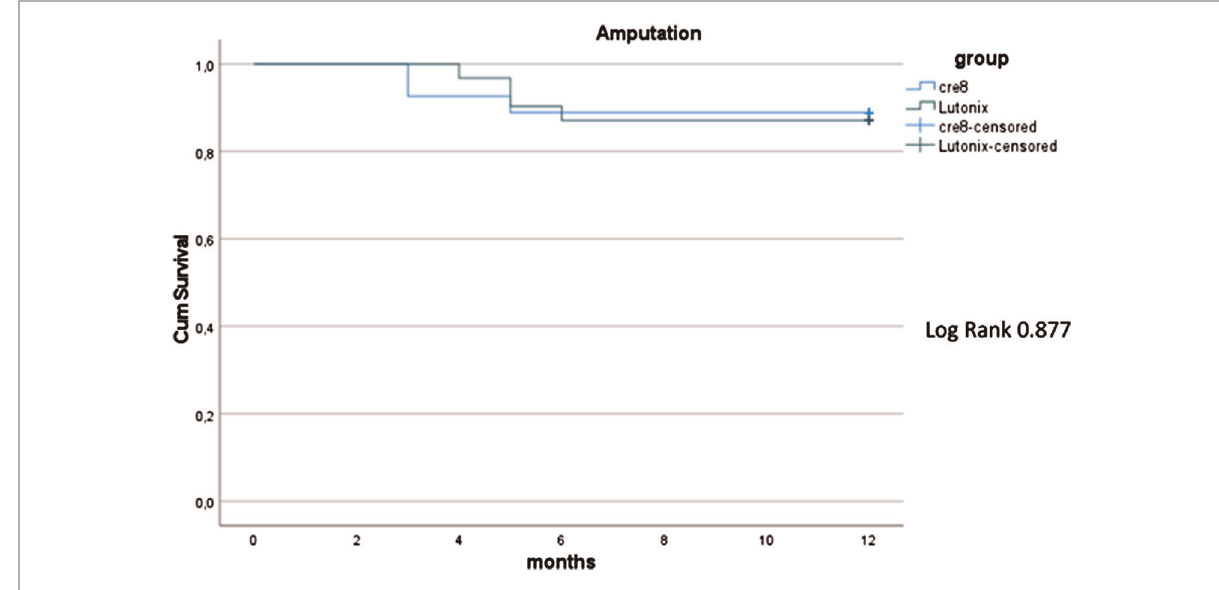
FIGURE 1 Amputation rate of 2 groups using Kaplan – Meier method.